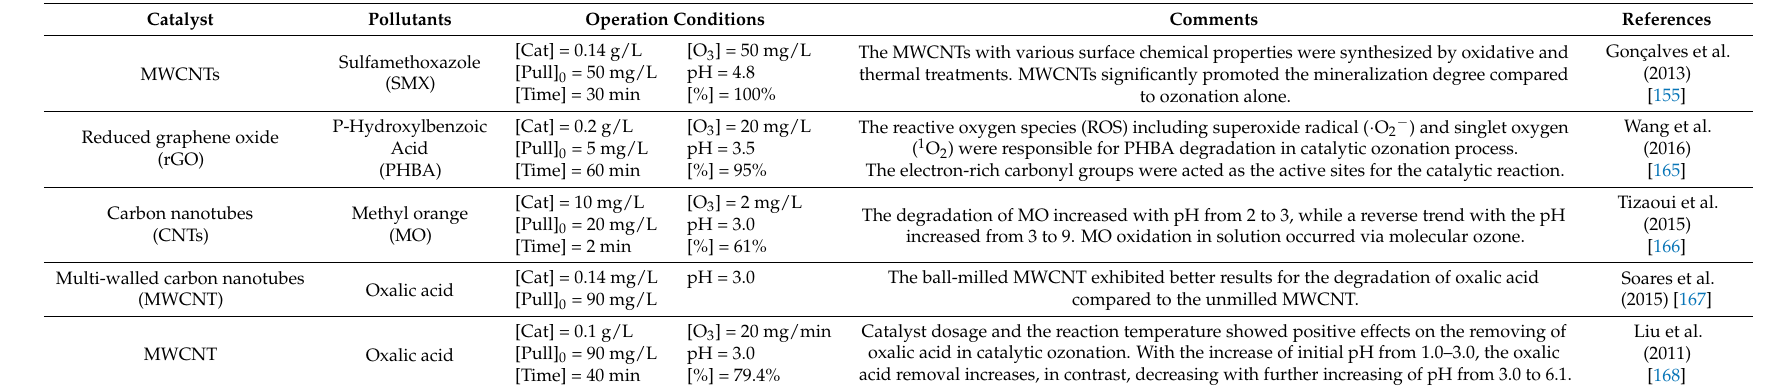
Table 10. Carbon materials for catalytic ozonation